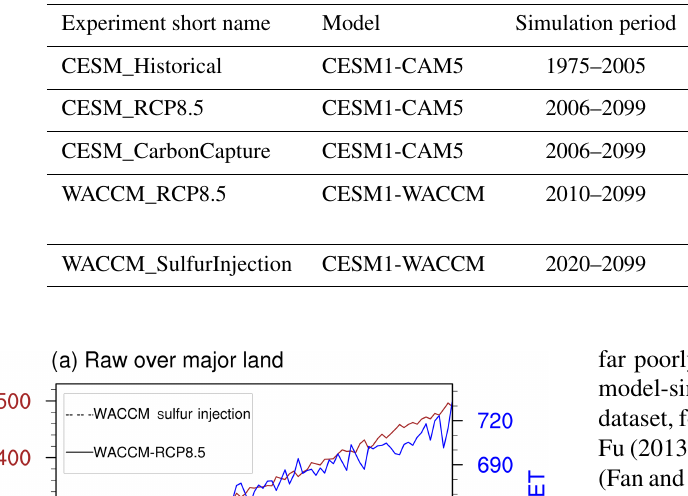
Table 1. The model experiments.